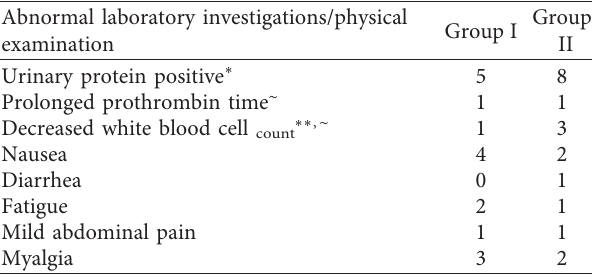
Table 7: Laboratory